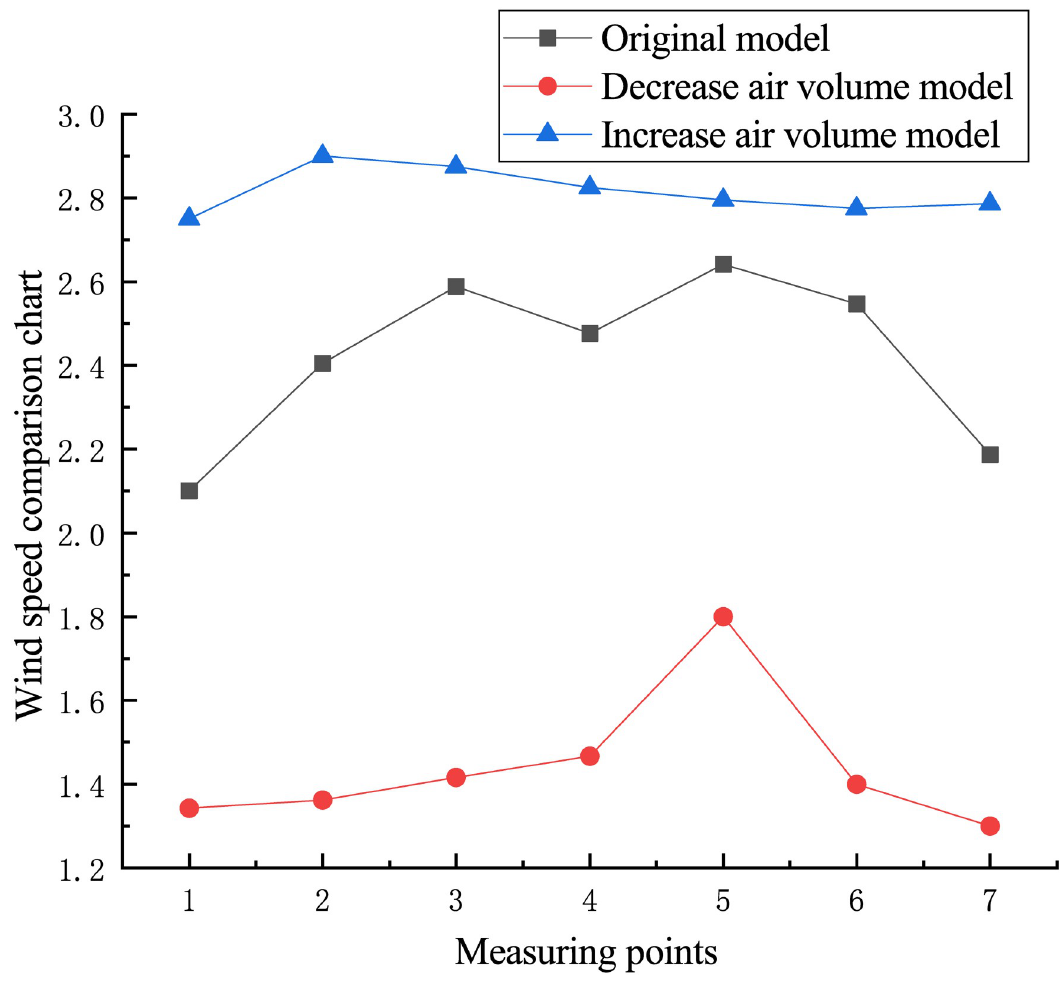
Fig 10. Wind speed comparison of different